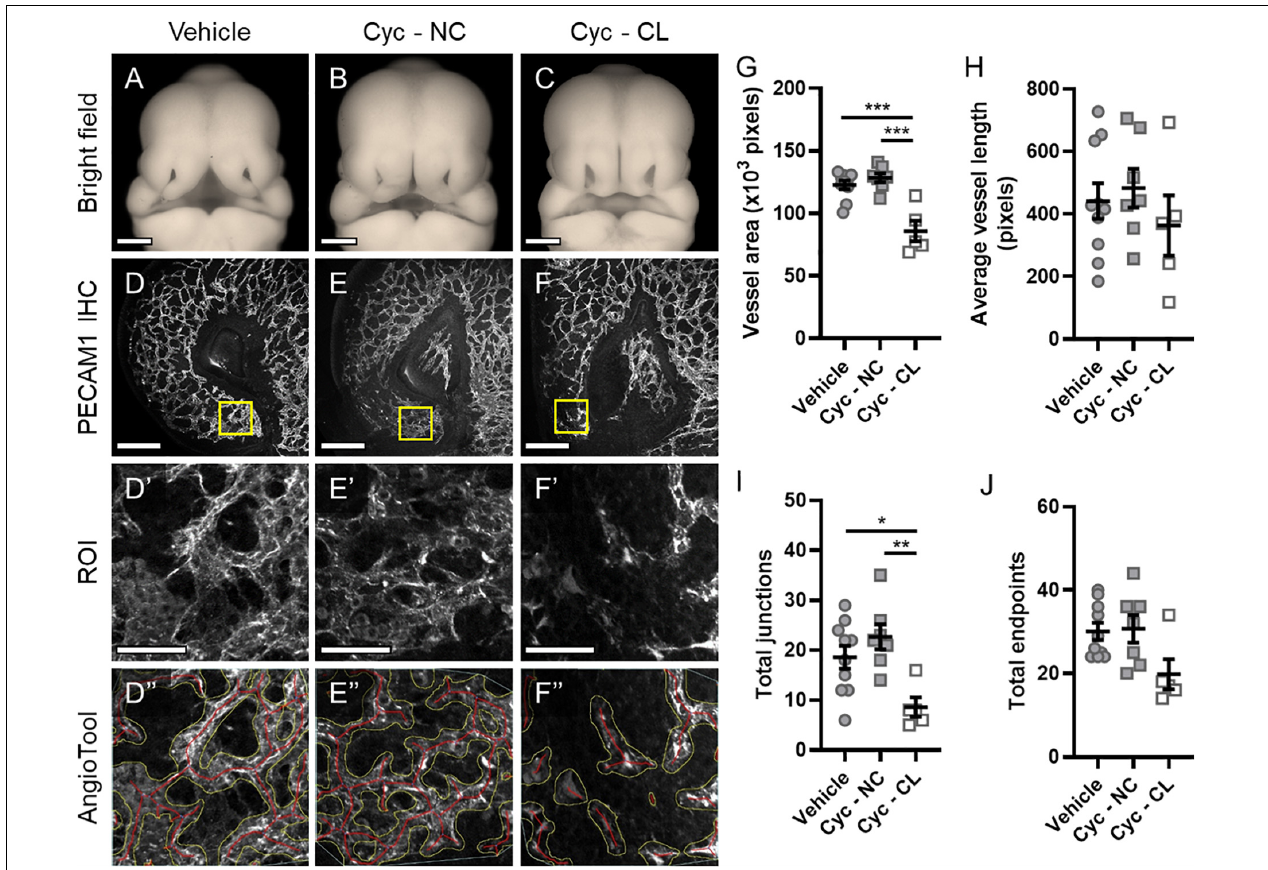
FIGURE 2 | Microvascular patterning is disrupted in cyclopamine-exposed embryos with cleft lip phenotype. (A–C) Representative phenotypes in GD11 embryos transiently exposed to vehicle and cyclopamine (cyc) and fixed in Bouin’s solution were imaged. Cyclopamine-exposed embryos were classified as having a non-clefted (NC) or cleft lip (CL) phenotype for analysis. Scale bars are 500 µ m. (D–F) One lambdoidal junction of each vehicle- and cyclopamine-exposed embryo fixed in 4% PFA was sectioned by vibrating microtome at 400- µ m thickness and stained for PECAM1 by whole-mount immunohistochemistry (IHC) to visualize the microvasculature. Maximum projections of the rostral-most 50 µ m of the resulting 3D confocal images are shown. Scale bars are 200 µ m. (D’–F’) Regions of interest (ROIs) were defined at the distal end of the medial nasal process (MNP) as indicated by the boxes in (D–F) . Scale bars are 50 µ m. (D”–F”) An overlay of vessels identified by AngioTool is shown for each ROI in (D’–F’) . The vessel areas are outlined in yellow and the vessels lengths are in red. Images are representative of 5–10 embryos per analysis group. (G–J) Vessel area, average vessel length, total junctions, and total endpoints in the ROIs were measured by AngioTool. Measurements for individual embryos are indicated by the icons, and the means ± SEM for each group are shown. * p < 0.05, ** p < 0.01, and *** p < 0.001 between indicated treatment